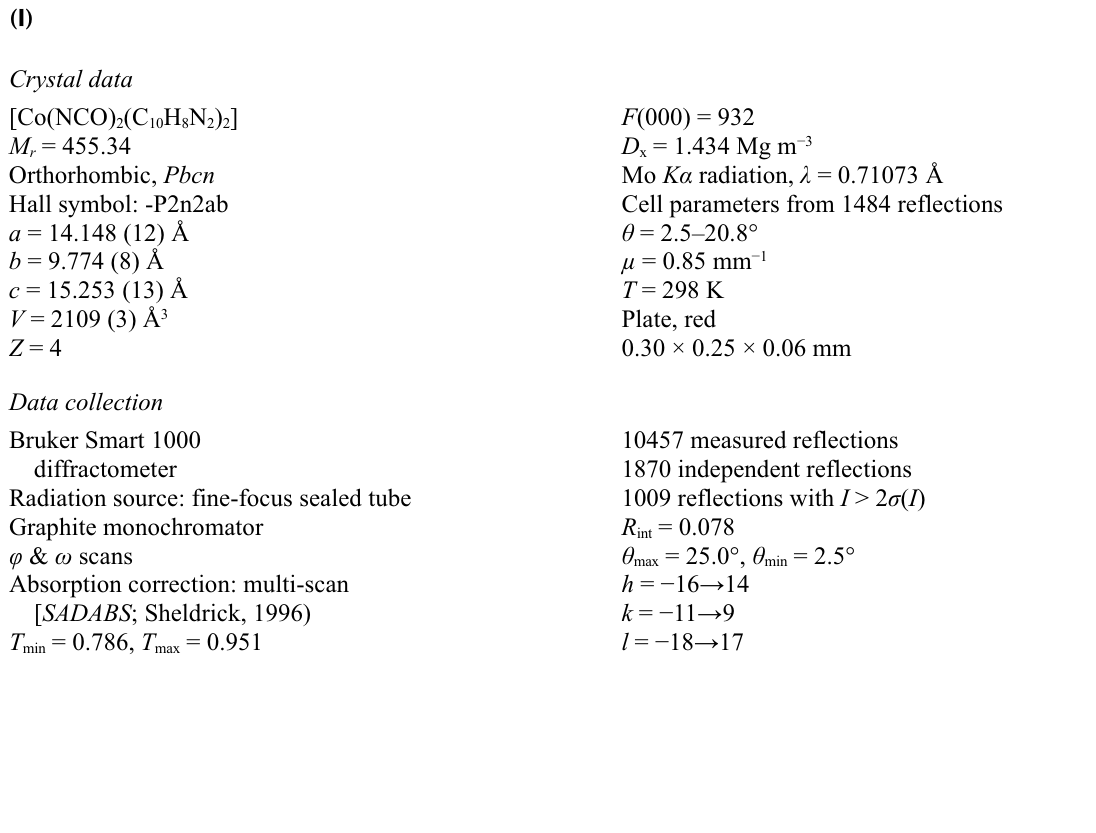
The crystal structure of the title compound showing the atomic numbering and 30% probability displacement ellipsoids. H atoms have been omitted for clarity. The second ligand is generated by i: –x+1, y ,